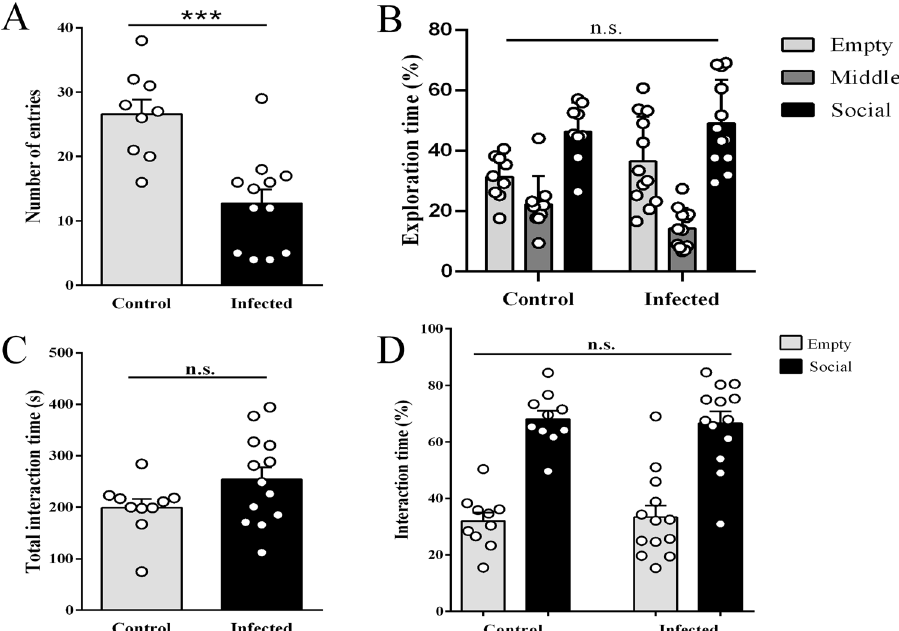
Figure 3. Chronic T. gondii infection did not alter social preference in mice. Infected mice had a reduced number of entries in chambers, indicating a decrease in locomotor activity during the test ( A ), but the percentual of exploration time in each chamber was similar between groups ( B ). Total interaction time with the cages was not significantly different between groups. All in-group differences were significant ( p < 0.0001%). ( C ). Moreover, control and infected mice presented a significant preference to explore the social cage ( D ). Asterisks indicate statistically significant differences and N.S. not significance. *** p < 0.001. Symbols correspond to individual subjects. Control (n = 10), infected (n = 13).